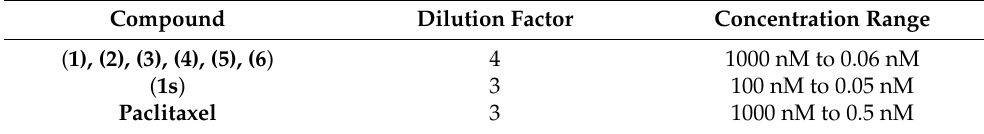
Table 3. Final compound concentration in the drug dose–response studies. Compound Dilution Factor Concentration